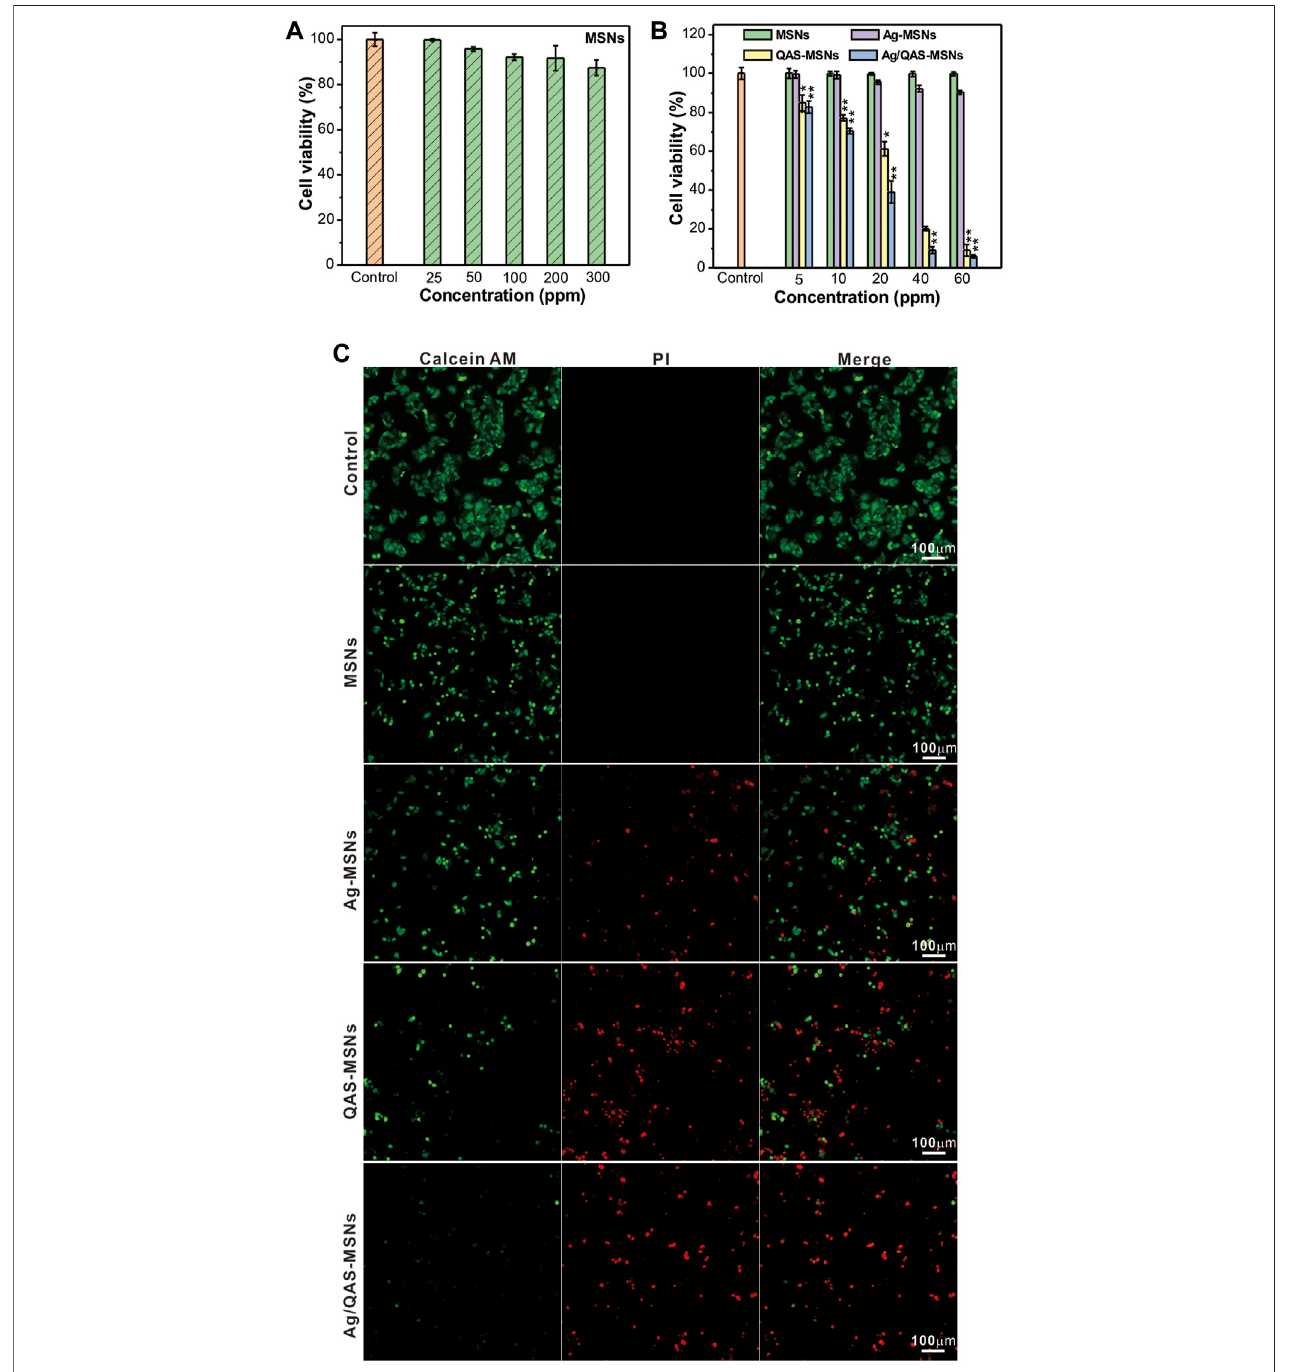
FIGURE 3 | (A,B) Relative survival of HepG2 cells treated with different concentrations of MSNs, Ag-MSNs, QAS-MSNs, and Ag/QAS-MSNs for 24 h. (C) Fluorescent images of HepG2 cells incubated with MSNs, Ag-MSNs, QAS-MSNs, and Ag/QAS-MSNs at concentration of 40 ppm. The cells were stained with calcein- AM and PI double fl uorescent dye. Green indicates live cells, and red indicates dead cells. All data are presented as the mean of three different measurements ± SD, asterisks (*) represent the signi fi cant difference from the control group using the Bonferroni posttest ( p ≤ 0.05) and asterisks (**) p <